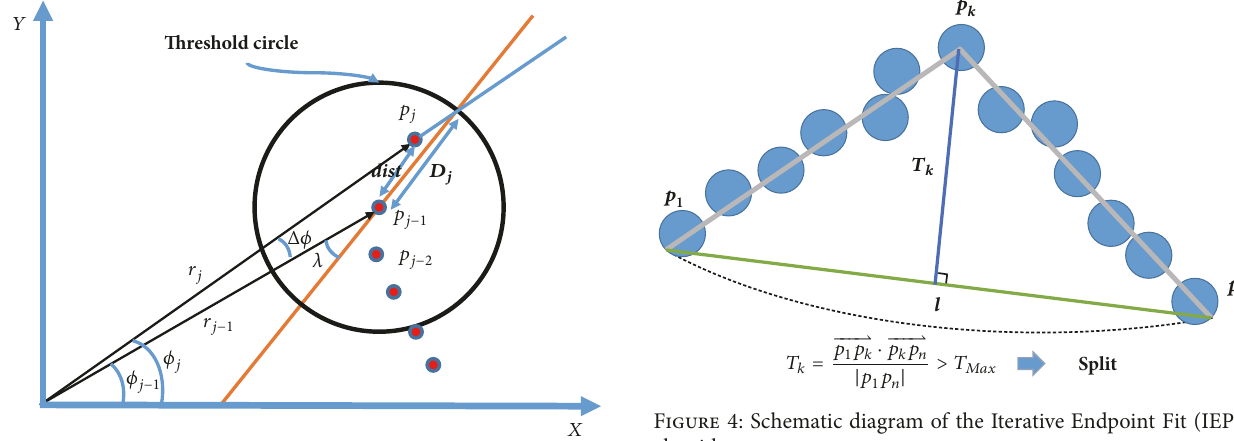
Figure 3: Schematic diagram of the threshold circle of the Adaptive Breakpoint Detector algorithm.